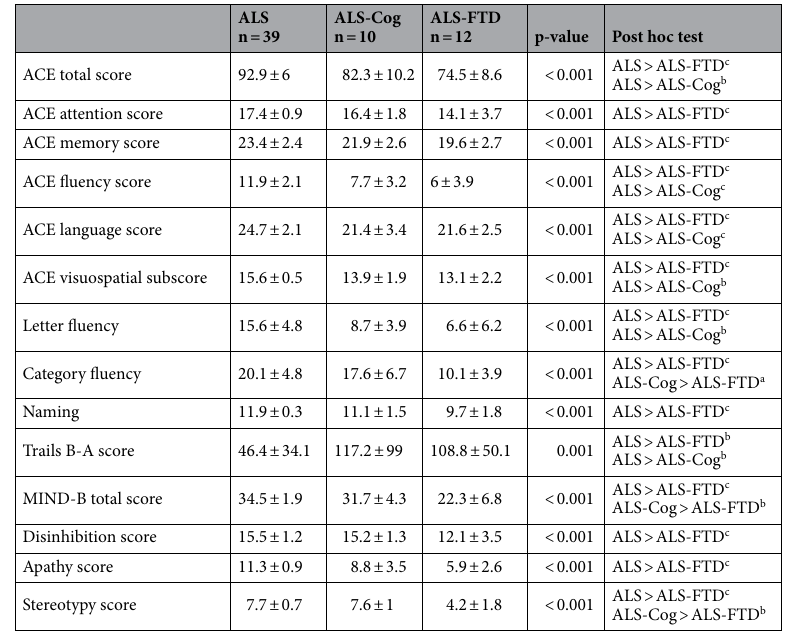
Table 2. Cognitive and behavioural profile. Distribution of cognitive and behavioural features across the ALS phenotypes is shown. Cognition was measured on the Addenbrooke’s cognitive examination (ACE) score including subdomain scores and additional executive function measures are shown. Behavioural profile was described on the motor neuron disease behavioural (MiND-B) scale. a 0.01 < p < 0.05; b 0.001 < p < 0.01; c p < 0.001, NA = not applicable.